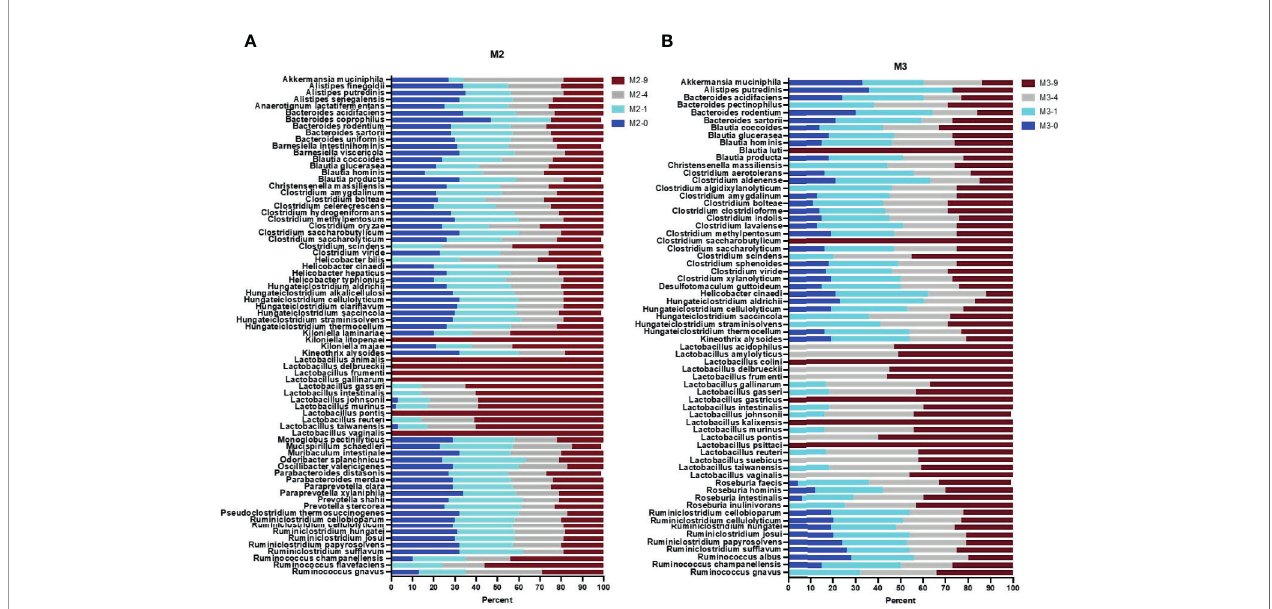
FIGURE 3 | Full length 16S rRNA gene sequence-based taxonomic classi fi cation of bacteria in mouse stool samples. Plots in panels (A, B) show relative abundance of detected species at four bead-beating conditions in M2 and M3 stool, respectively. The x-axis shows the percentage of reads supporting the taxon and the y-axis shows the detected species. In the sample ID, M represent Mouse and -0, -1, -4, and -9 represent bead-beating time in the experiment.